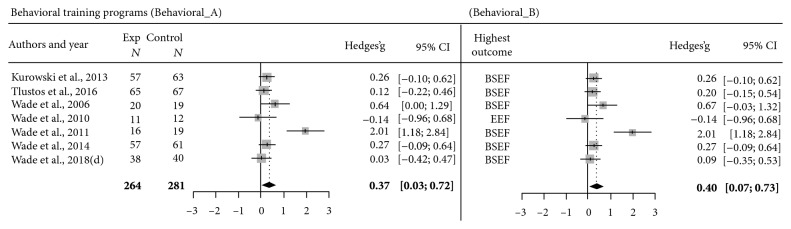
Forest plots showing the number of participants per group, effect size estimates (Hedges's g), and 95% confidence interval of each study, comparing behavioral training outcomes with control condition's outcomes. Model Behavioral A depicts the meta-analytic model that considers, for each study, an aggregated mean representing the mean value of the various outcomes relative to all behavioral domains. Model Behavioral B depicts the meta-analytic model that considers, for each study, the highest outcome domain. Note: BSEF = behavioral, social, and emotional functioning; EEF = everyday executive functioning.